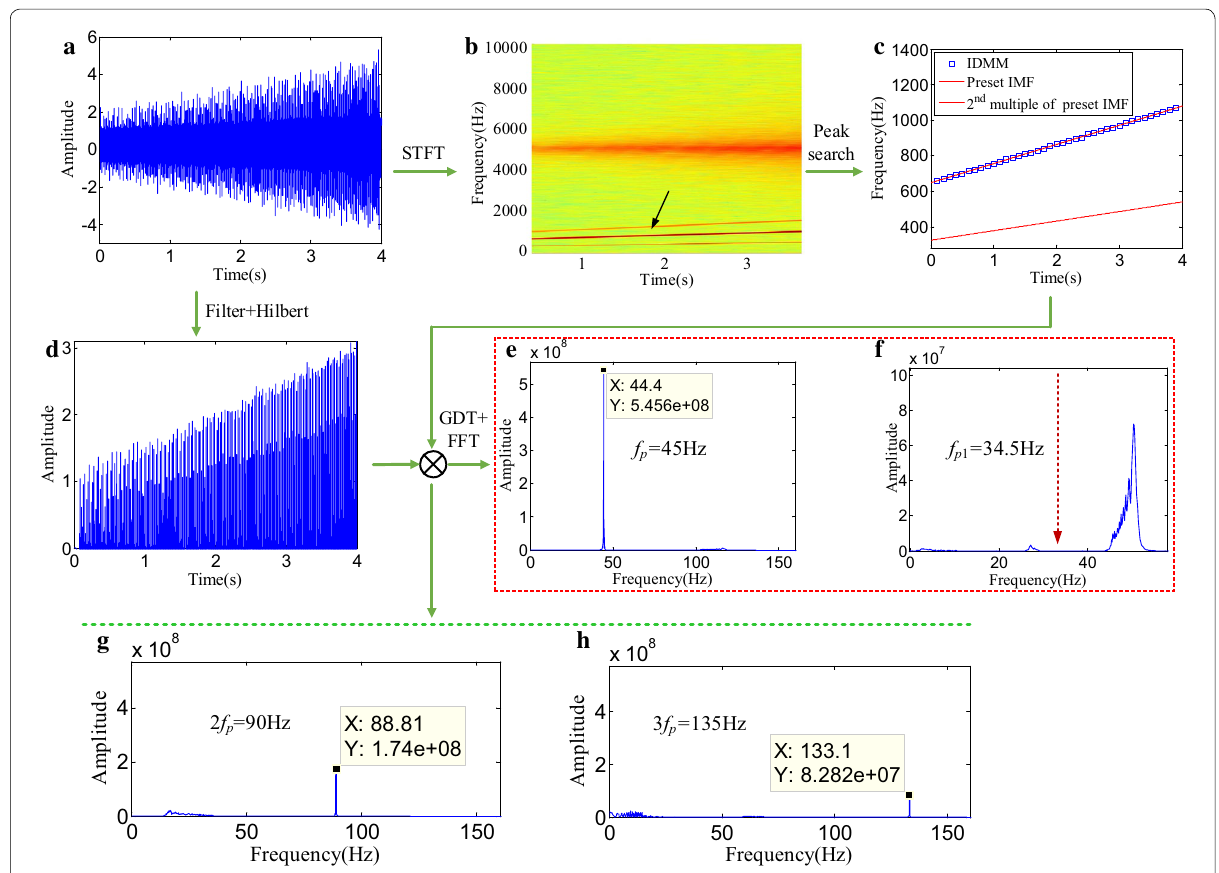
Figure 6 Analysis results of simulated signal: a simulated signal, b TFR of simulated signal, c IDMM and preset IMF, d envelope of filtered signal; and spectra of demodulated signals with different PFs: e s 0 ( t ), f s 1 ( t ), g 2 s 0 ( t ), h 3 s 0 ( t )